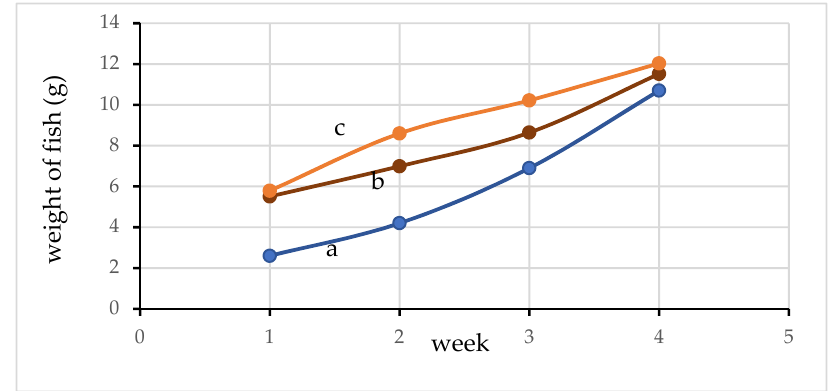
Figure 10. The fish growth observed in ( a ) pond 1; ( b ) pond 2; ( c ) and pond 3.